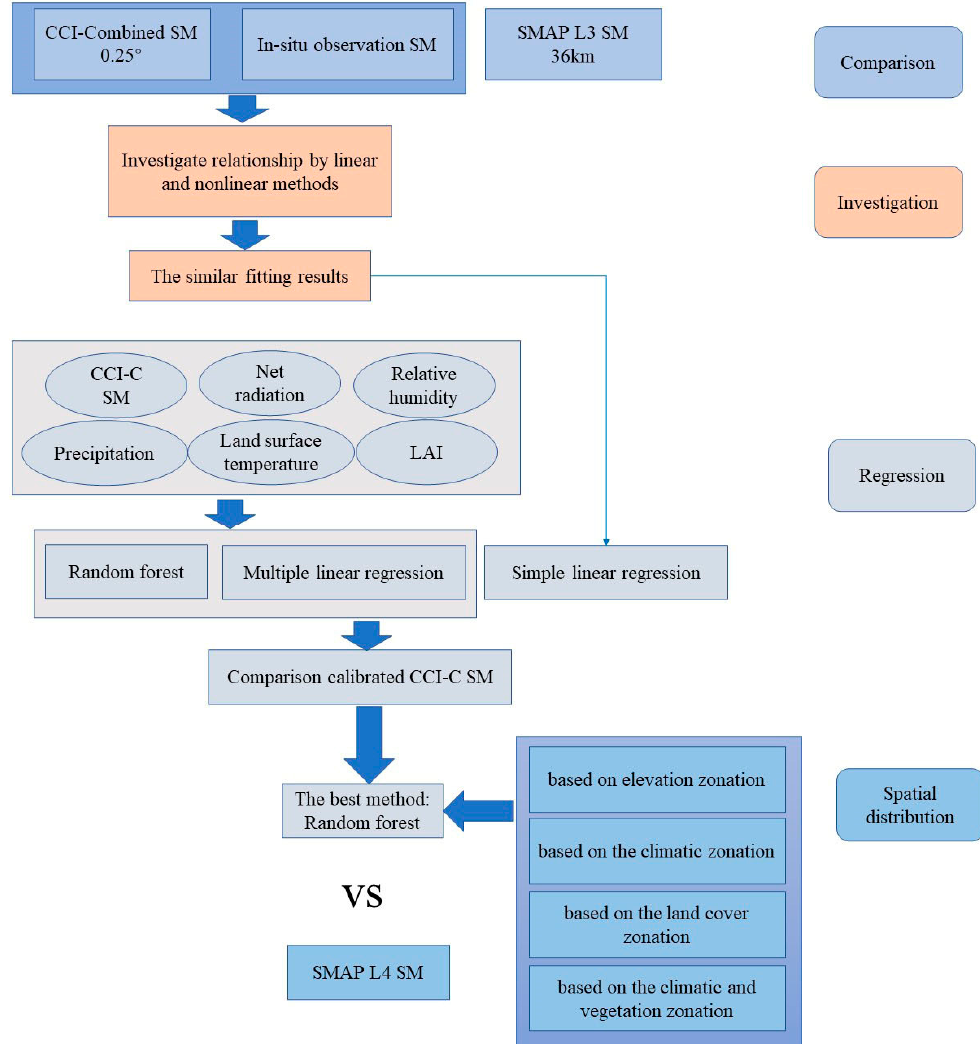
Figure 2. The flowchart of